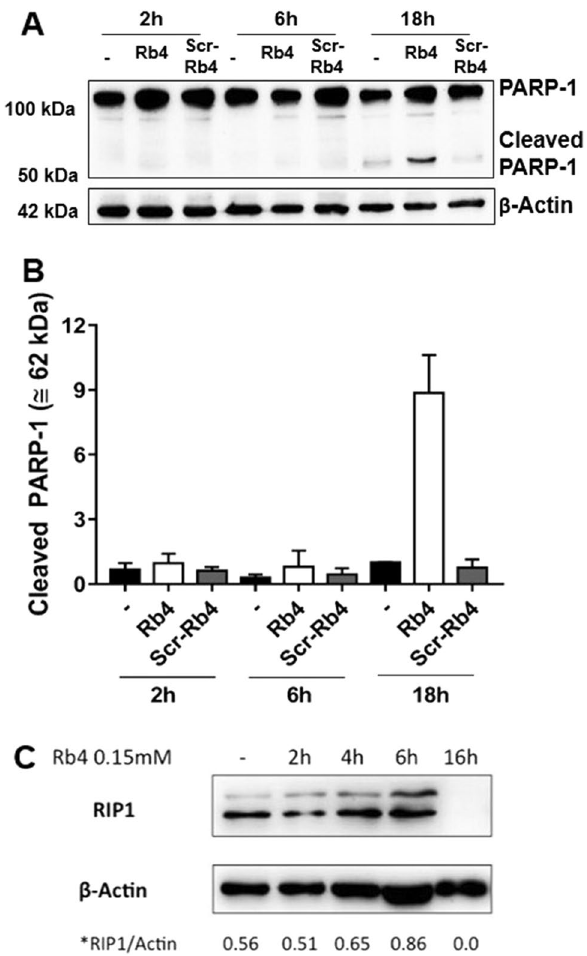
Figure 5. Rb4, but not Scr-Rb4, triggers PARP-1-mediated necrosis independently of RIP-1 in murine melanoma cells. ( A ) Western blotting of PARP-1 after Rb4 treatment of melanoma cells samples analyzed by immunoblotting shows a cleaved band at 62 kDa when compared to Scr-Rb4 and untreated controls. ( B ) PARP-1 cleaved band increased ninefold in Rb4 treated cells when normalized by β–actin expression and compared to both controls. ( C ) Immunoblotting of RIP-1 was also performed showing no RIP1 expression after 16 h. Representative blots from at least three independent experiments are shown. Full length blots are shown in Supplementary Figure